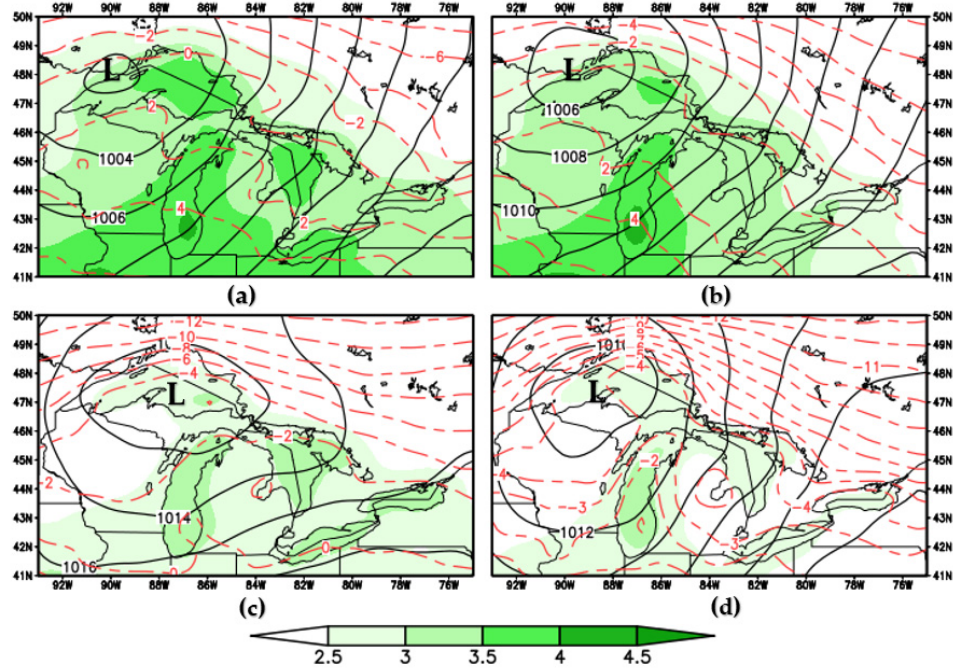
Figure 7. MSLP (solid black contours; mb), 1000 mb temperature (dashed red contours; °C), and 2-m specific humidity (shaded green; g kg − 1 ) for Cluster 1 ( a ), Cluster 2 ( b ), Cluster 3 ( c ), and the LES composite ( d ) while the clipper was located at 90° W.